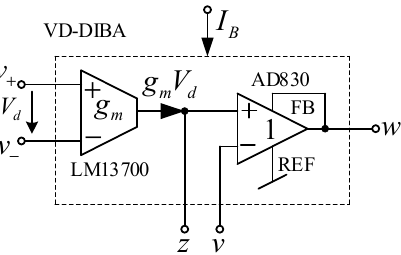
Figure 31. VD-DIBA based on commercial components.